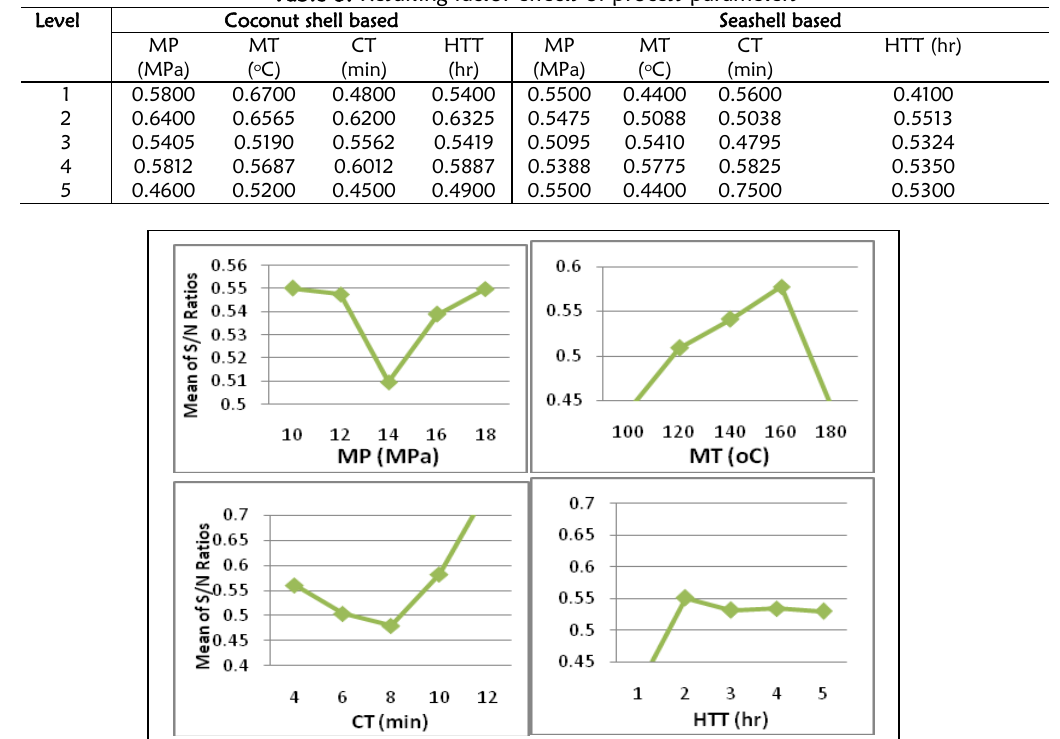
Table 6: Resulting factor effects of process parameters